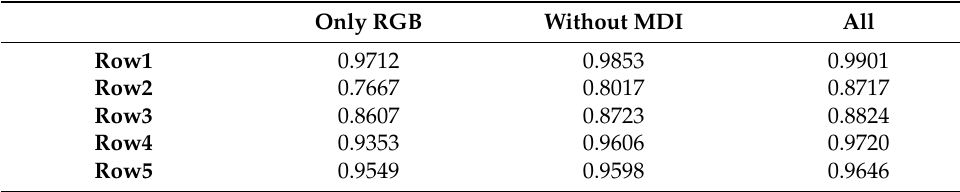
Table 7. The IoU for data in Figure 12 from rows 1 to 5. Only RGB Without MDI